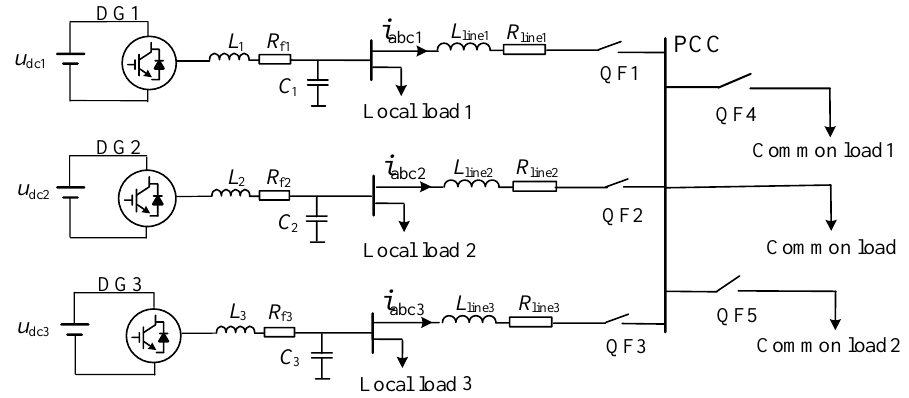
Figure 1. Topological structure diagram of multi-DGs hybrid master – slave control .